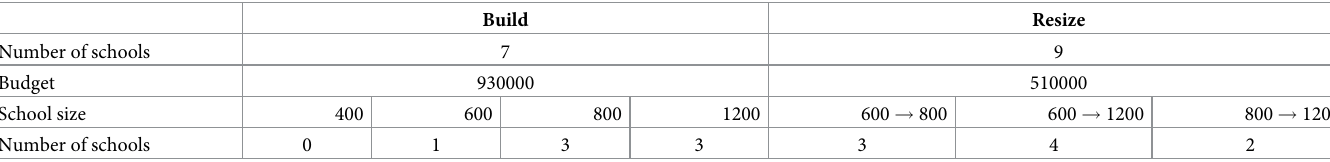
Table 2. Updates in the 2010-2015